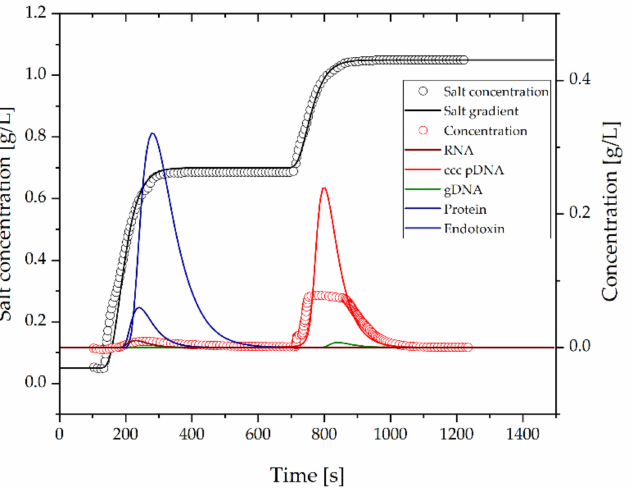
Figure 10. Comparison of literature data (symbols) and simulation results